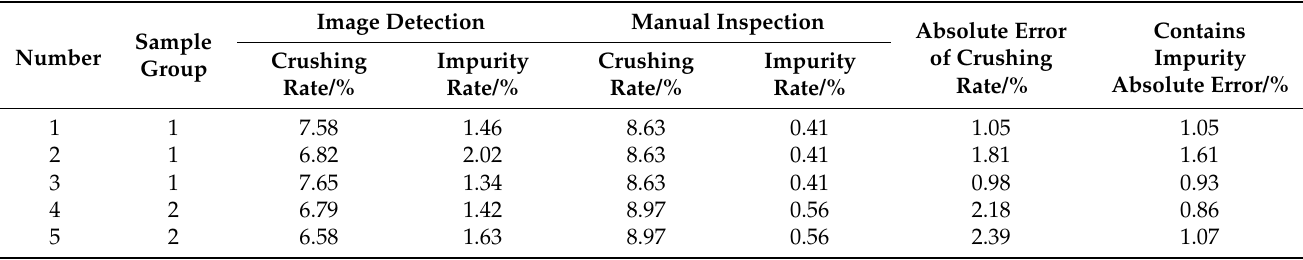
Table 8. The results of the first experiment were dynamically monitored for the yield of harvested maize grains’ impurity and crushing